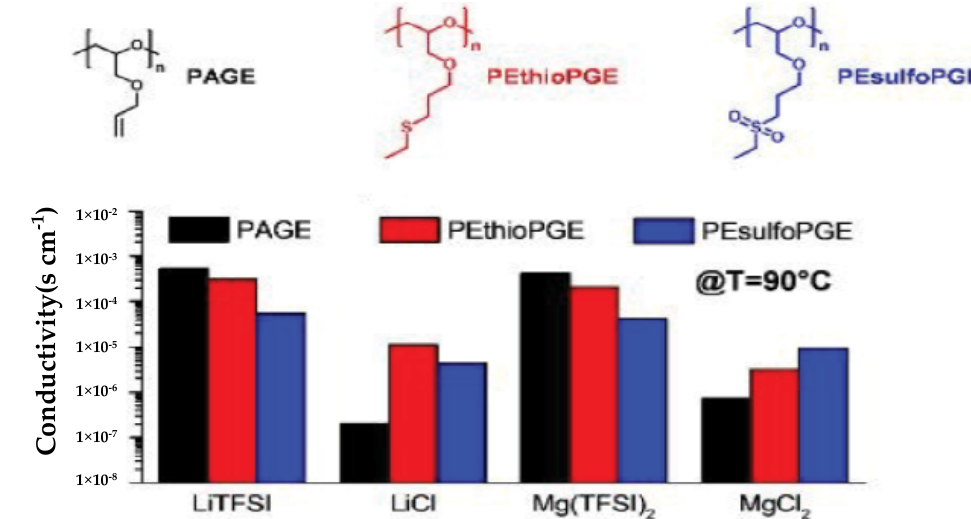
Figure 5. Adapted with permission from reference [192]. Copywrite 2020. Royal Society of Chemistry. Bar graph comparing the conductivities at 90 ◦ C of lithium and magnesium salt complexes in the three polymer matrices shown above the